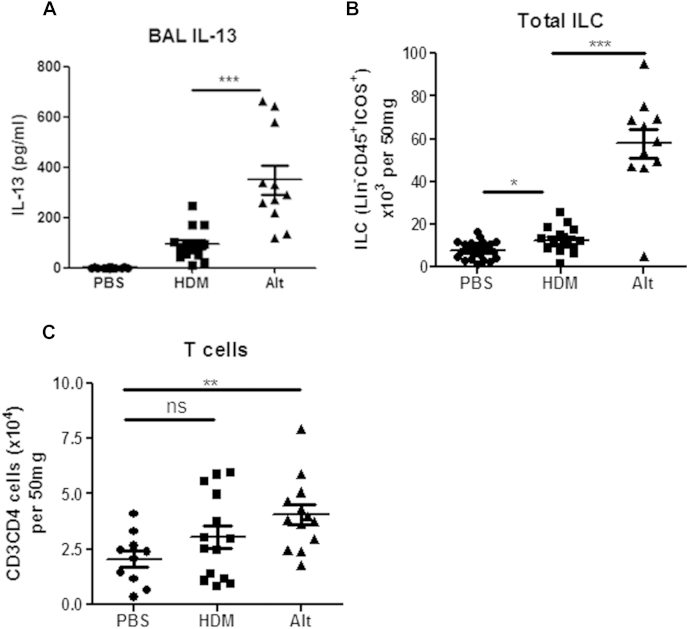
Neonatal BALB/c mice were exposed to intermittent intranasal A alternata (Alt), HDM, or saline (PBS) for 3 weeks. Total BAL fluid IL-13 levels were measured by means of ELISA (A), and numbers of Lin−CD45+ICOS+ ILCs (B) and CD3+CD4+ T cells (C) were quantified by means of flow cytometry. *P < .05, **P < .01, and ***P < .001. ns, Not significant.